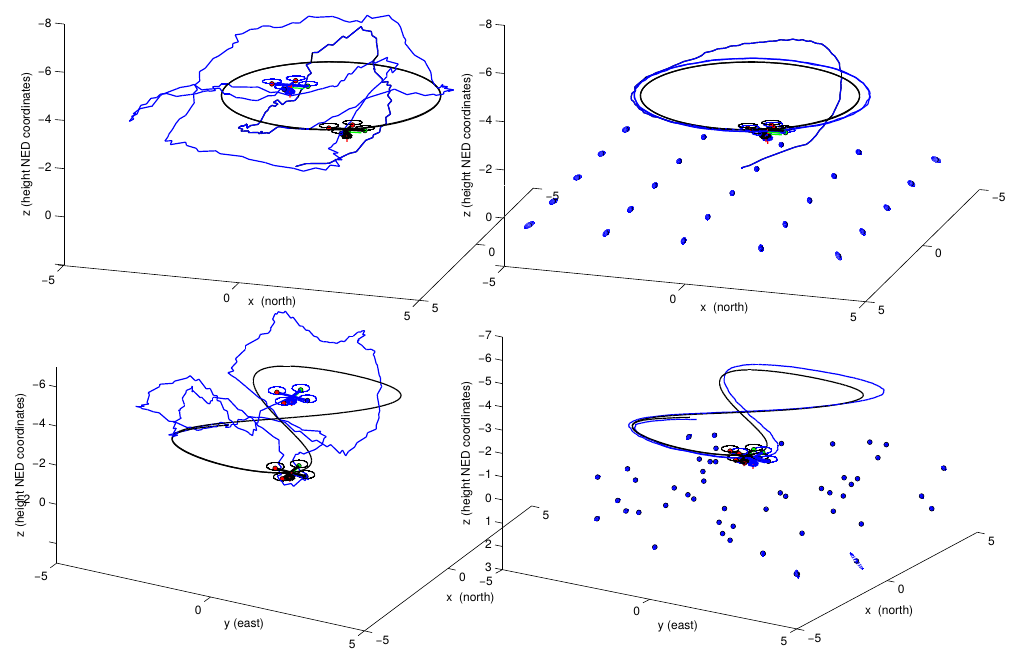
Figure 9. Comparison of the estimated trajectories obtained by filtering GPS data ( left plots ), and the estimated maps and trajectories obtained through visual-based navigation ( right plots ). Two different kind of trajectories and distributions of landmarks are simulated: ( upper plots ) a circular trajectory, ( lower plots ) a figure-eight-like trajectory. The GPS signal was used only during the initialization period. The actual trajectory is shown in black. The estimates are shown in blue.